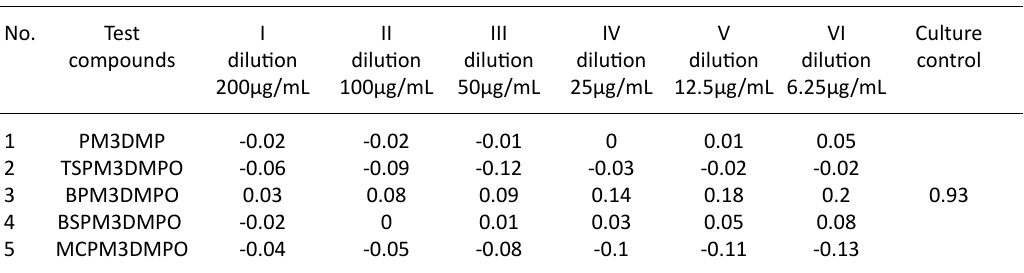
Table 11. MIC of Piperidines against Klebsiella sp . at 600 nm